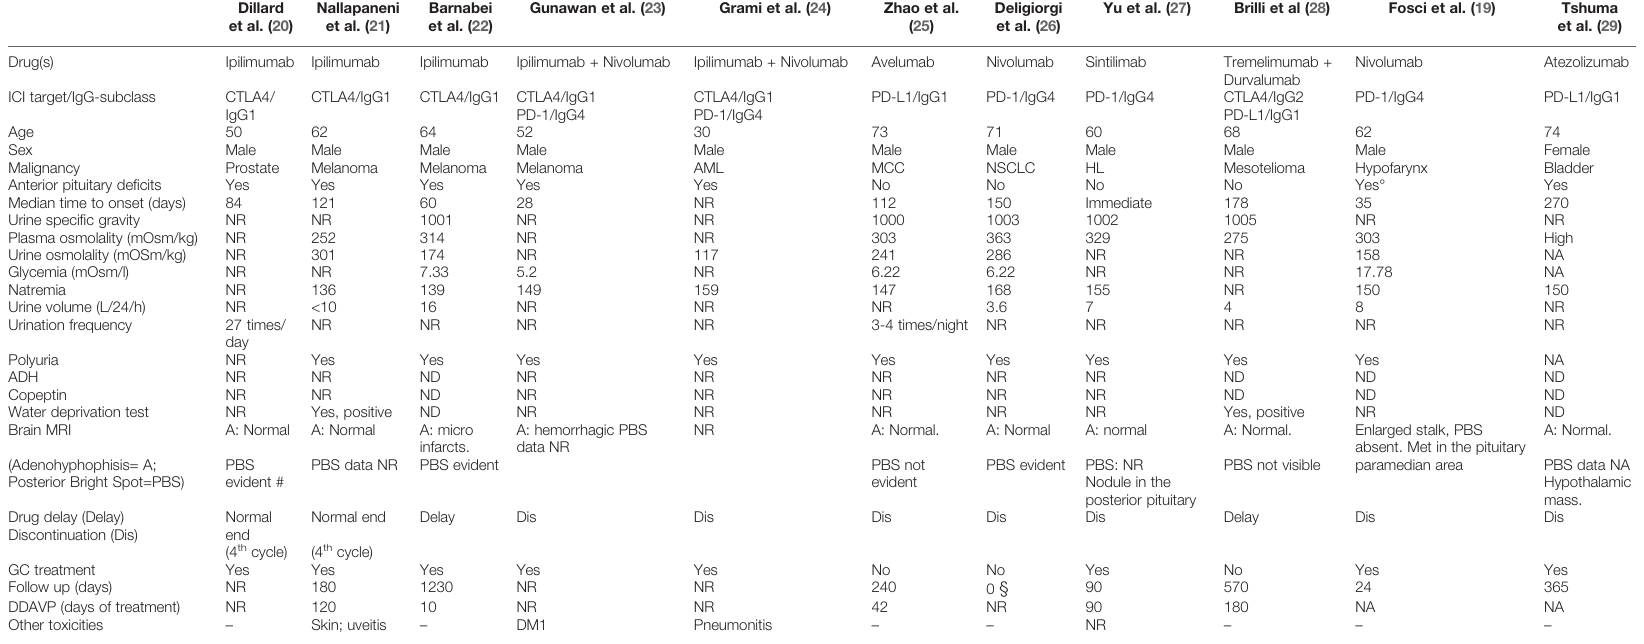
TABLE 1 | Clinical data extracted by the current literature on ICI-induced CDI.